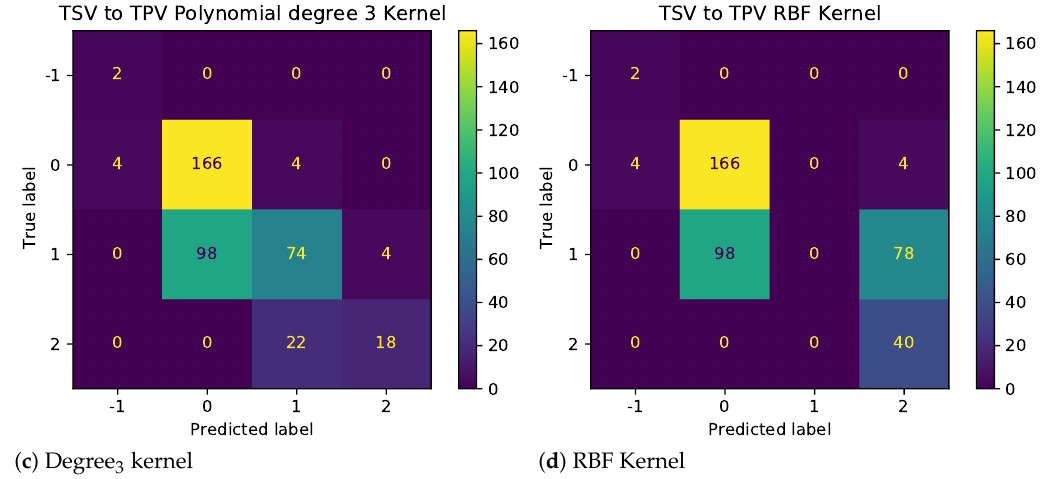
Figure 9. Confusion Matrix for different SVM Kernels with reduced illogical